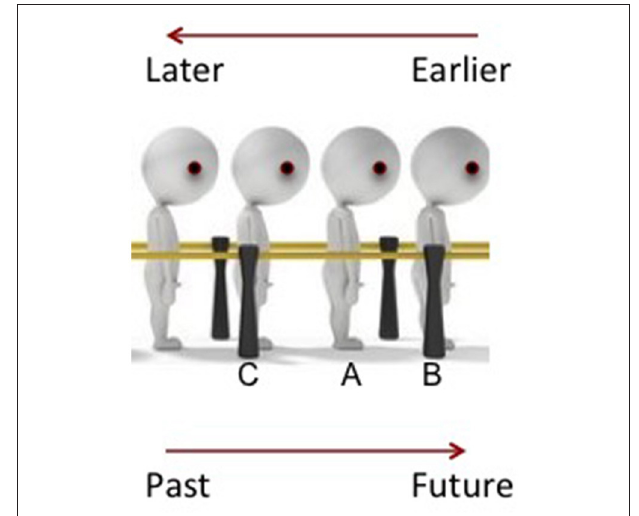
FIGURE 1 | Illustration of a framework proposed by Yu (2012). (A–C) refer to the individual of interest, the person who arrived earlier at the line and the person who arrived at a later point in